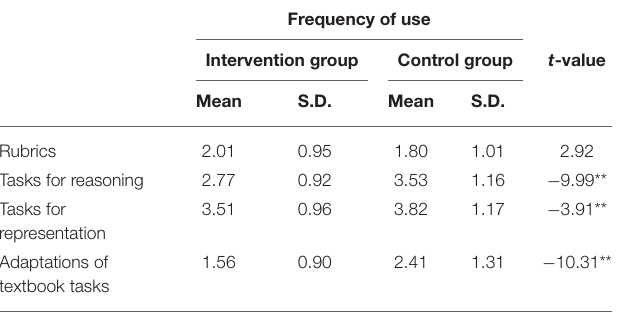
TABLE 3 | Means, standard deviations, and t -values for group differences in how frequently teachers used four aspects of assessment 5 months after the project finished